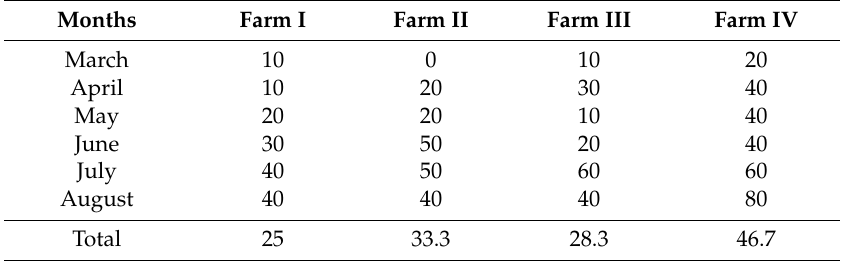
Table 5. Monthly prevalence of motile Aeromonads isolated from fish samples in the examined farms.